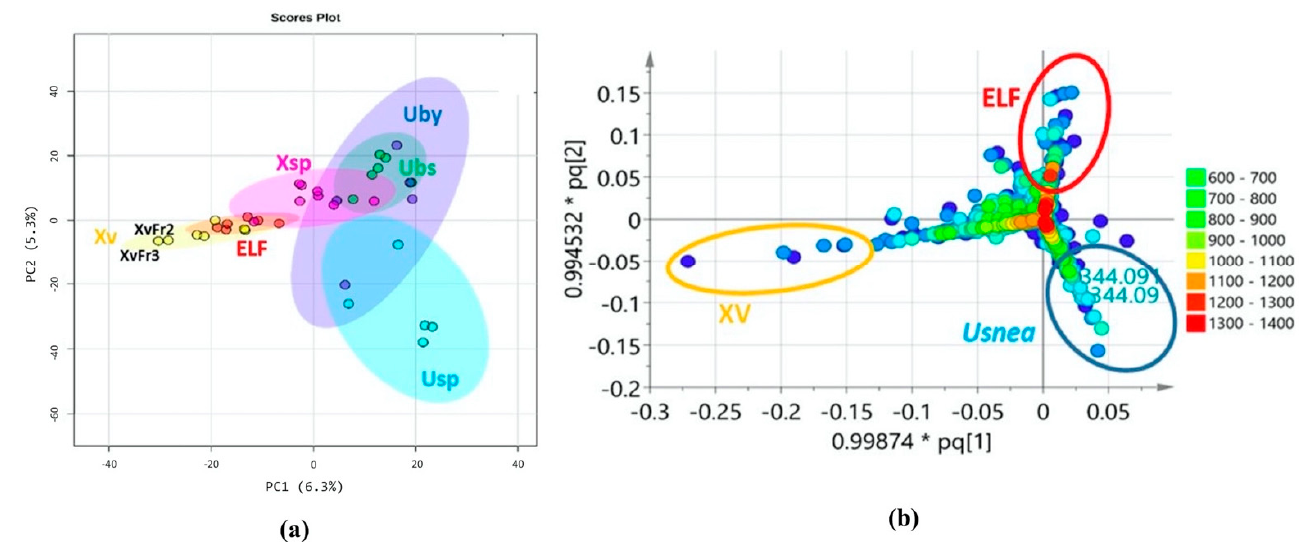
Figure 3. Multivariate analyses of the LC–MS data of 36 lichen and ELF crude extracts (including the reference (+)-usnic acid) and selected fractions. ( a ) principal component analysis (PCA) scores plot revealed distinct Xv fractions away from the overlapping clusters. ( b ) Encircled features on partial least squares discriminant analysis (PLS-DA) loading plot generated from SIMCA revealed metabolites (in molecular weight) responsible for the separation of the respective taxonomical groups. (ELF: endolichenic fungi, UBS: U. bismolliuscula, UBY: U. baileyi, USP: U. pectinata, XSP: Xylaria sp., XV: X. venustula ). The pq vectors indicate 99.87% and 99.45% influence of individual X- and Y-variables, respectively, to the model suggesting very good prediction of underlying patterns in the data.